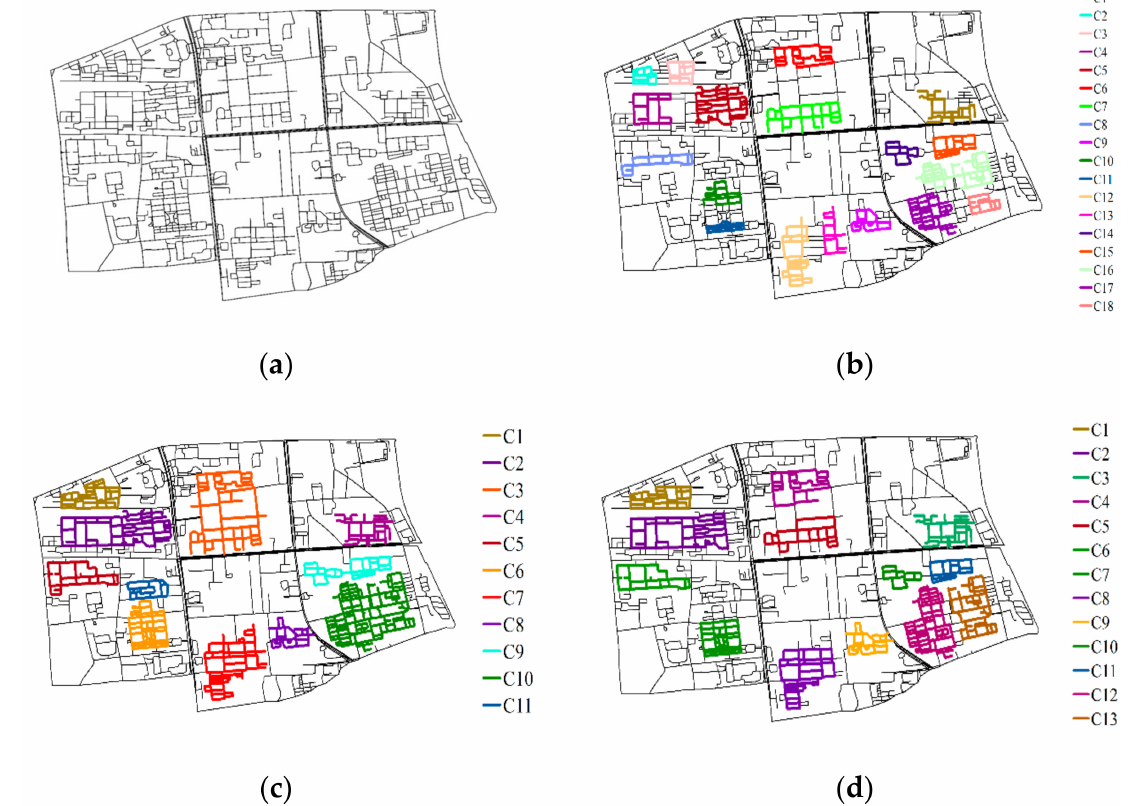
Figure 3. Simulated datasets: ( a ) road network; ( b ) 18 spatial communities at snapshot 1; ( c ) 11 spatial communities at snapshot 2; ( d ) 13 spatial communities at snapshot 3.